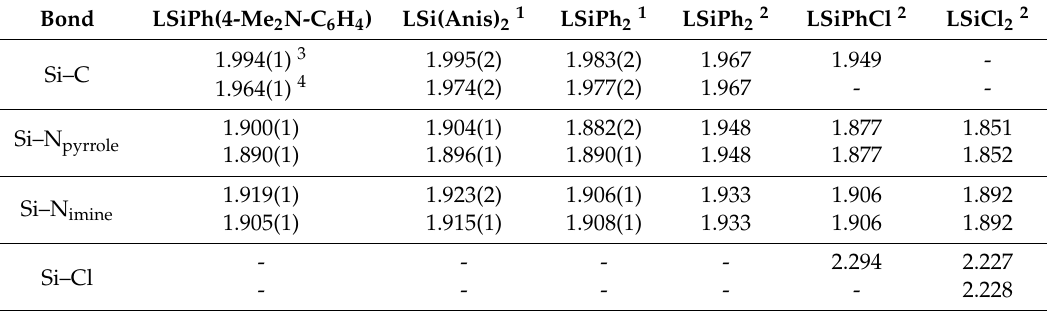
Figure 2. Molecular structures of (from left) LSiPh 2 , LSi(Anis) 2 and LSiPh(4-Me 2 N-C 6 H 4 ) in their crystal structures (heteroatoms and Si-bound C atoms labeled, H-atoms, solvent molecules and second independent molecule of the asymmetric unit of LSiPh 2 and LSi(Anis) 2 are omitted). Table 2. Bond lengths (Å) in the Si coordination spheres of the hexacoordinate Si complexes discussed in this paper.